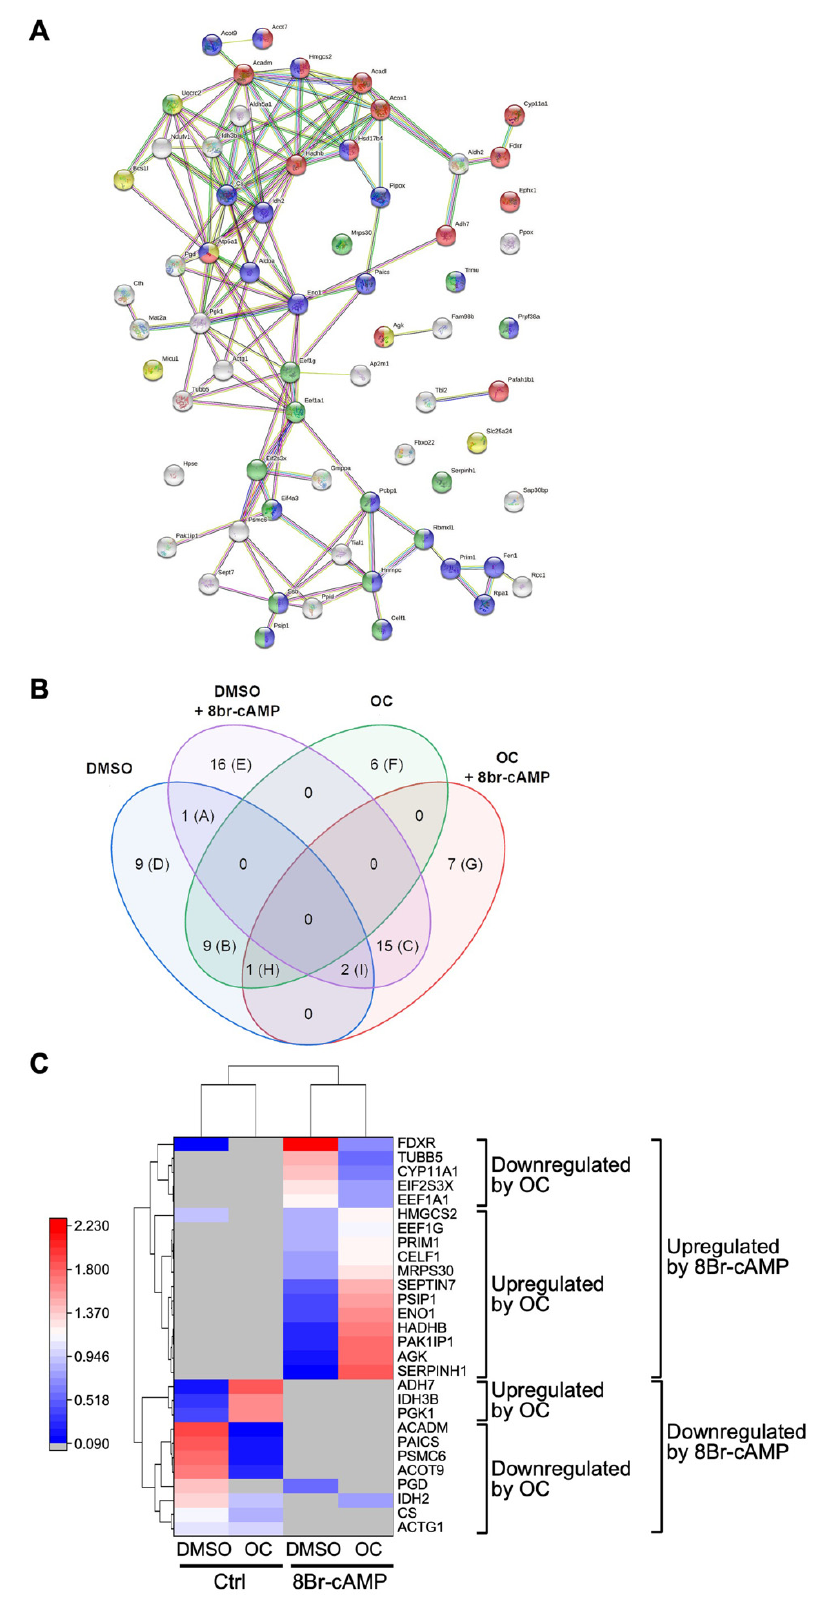
Figure 5. Proteomics profiling of Sample 2 shows proteins that are potentially affected after exposure of Leydig cells to an OC mixture. MA-10 Leydig cells were treated with either DMSO or 10 µg/mL of the OC mixture for 2 h and then treated for another 4 h with or without 0.1 mM 8Br-cAMP as indicated. Protein content in the spots corresponding to Sample 2 (yellow circles in Figure 3) was